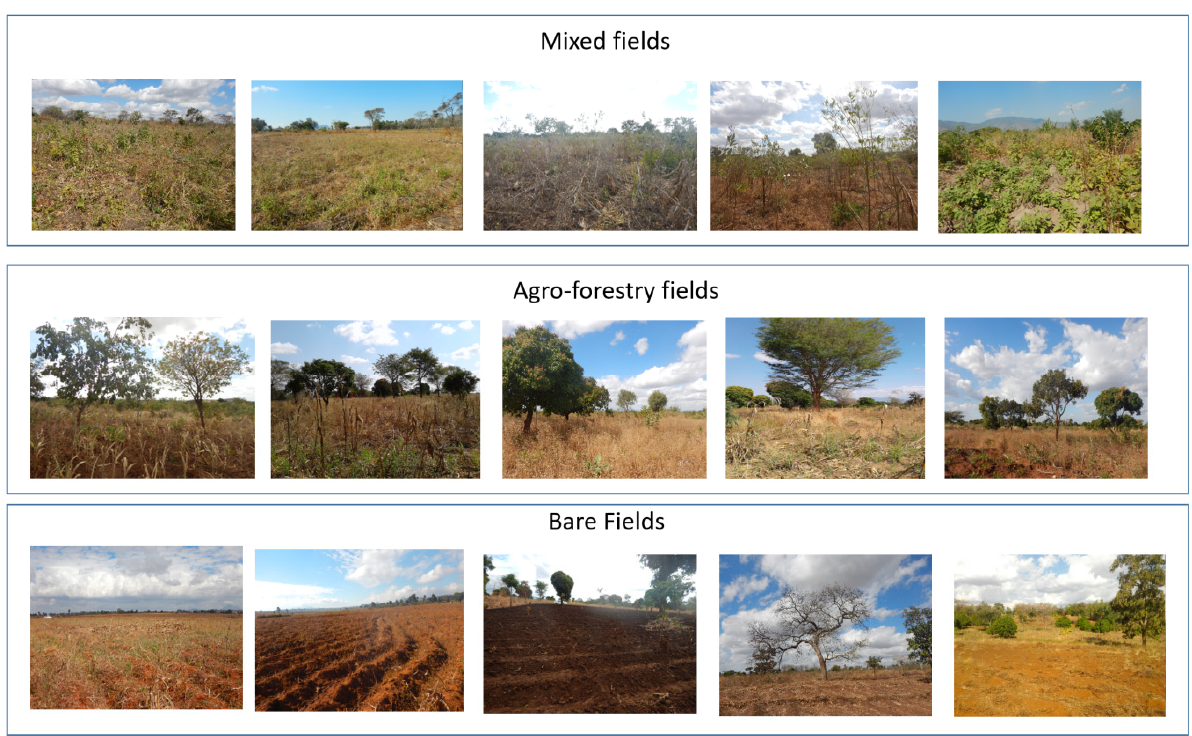
Figure 3. Photographs of agricultural landscapes taken in Summer 2018 across Dedza and Ncheu District, Malawi.